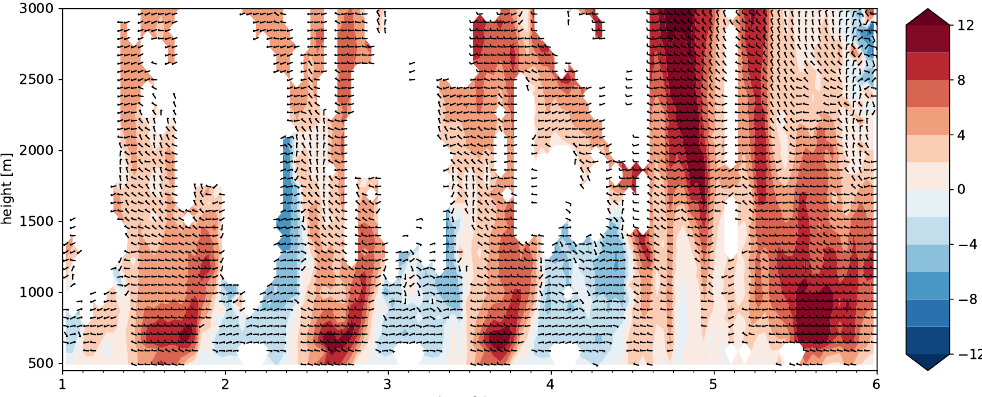
Figure 8. Time–height cross-section of along-valley wind speed (color) and wind direction (barbs) relative to valley’s axis for the low-mode wind profiler data combined with the weather station data for the first few days of September